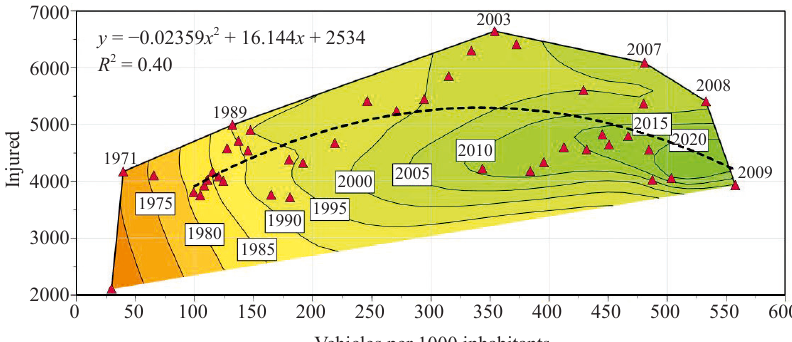
Figure 9. Car ownership and the number of